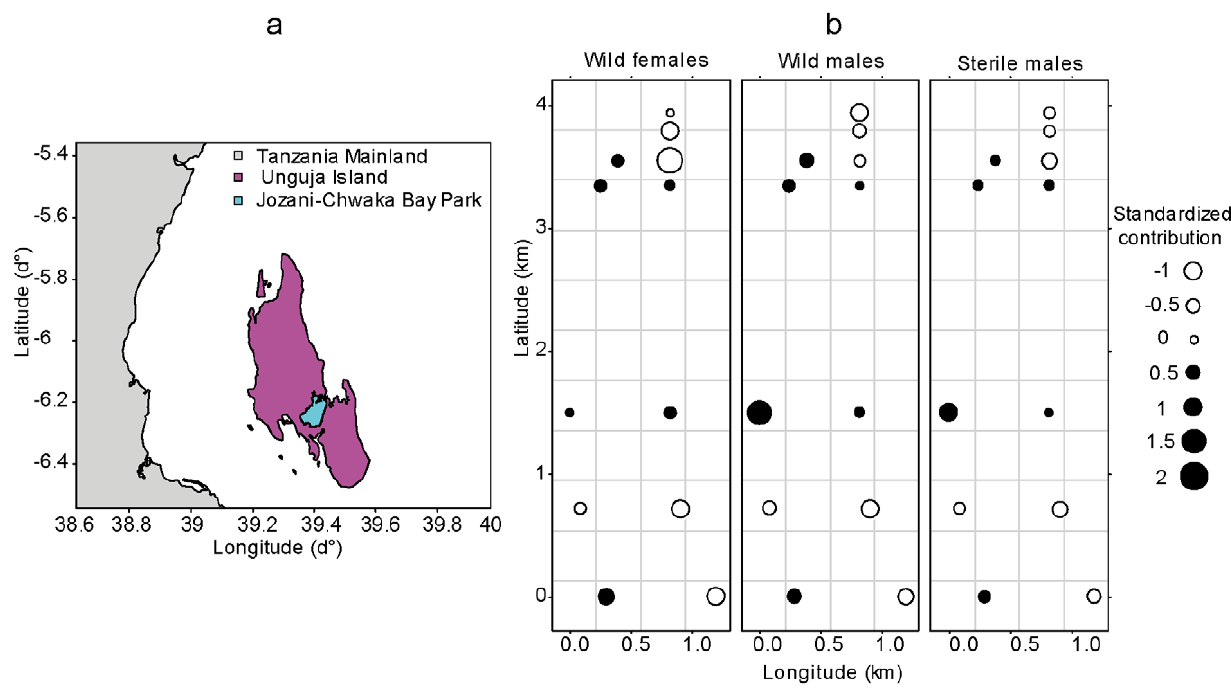
Figure 1. Description of the trapping system. (a) Unguja Island, and (b) spatial distribution (standardized abundance) of wild and sterile Glossina austeni as sampled with 12 sticky panel traps in the Jozani-Chwaka Bay National Park. See text for explanations on abundance standardization. Longitude and latitude are expressed in km, with the origin at the bottom left corner of the virtual rectangular box bounding trap locations.